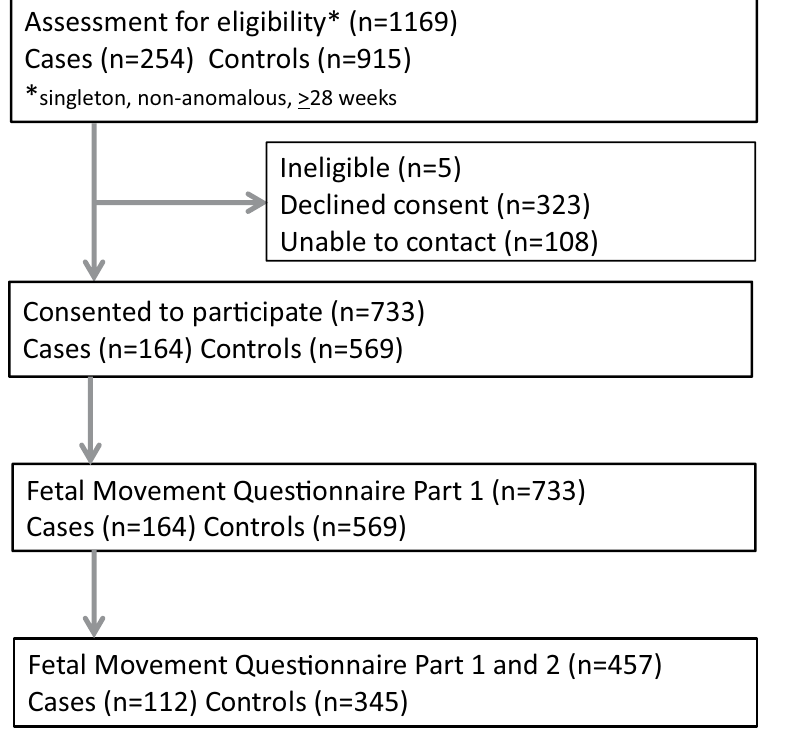
Figure 1. Participant